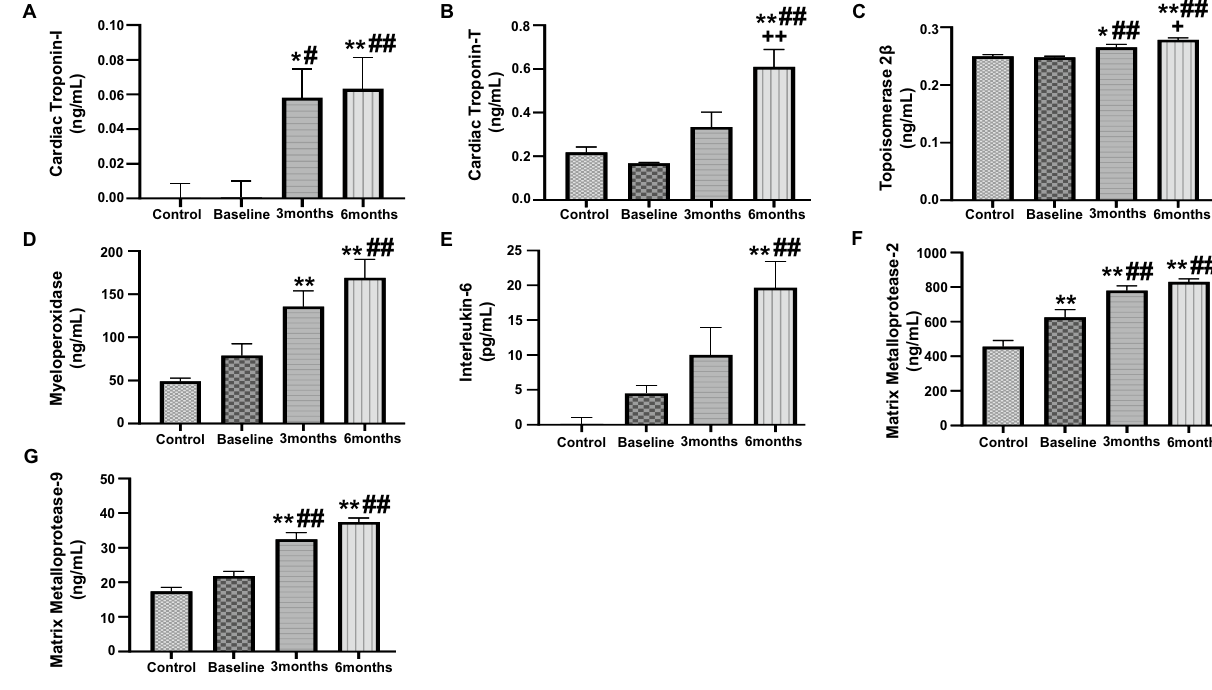
Figure 1. Quantitative analysis of plasma biomarkers in anthracycline-treated patient. Plasma concentrations of ( A ) Cardiac Troponin I, ( B ) cardiac Troponin T, ( C ) Topoisomerase 2β, ( D ) MPO, ( E ) IL-6, ( F ) MMP2 and ( G ) MMP9, assessed by ELISA. Values represent means ± SEM. *p < 0.05 vs. Control, **p < 0.01 vs. Control, # p < 0.05 vs. Baseline, ## p < 0.01 vs. Baseline, + p < 0.05 vs. 3 months, ++ p < 0.01 vs. 3 months. Control (n = 17) and patients with breast cancer (n = 17) at baseline, 3 months and 6 months.